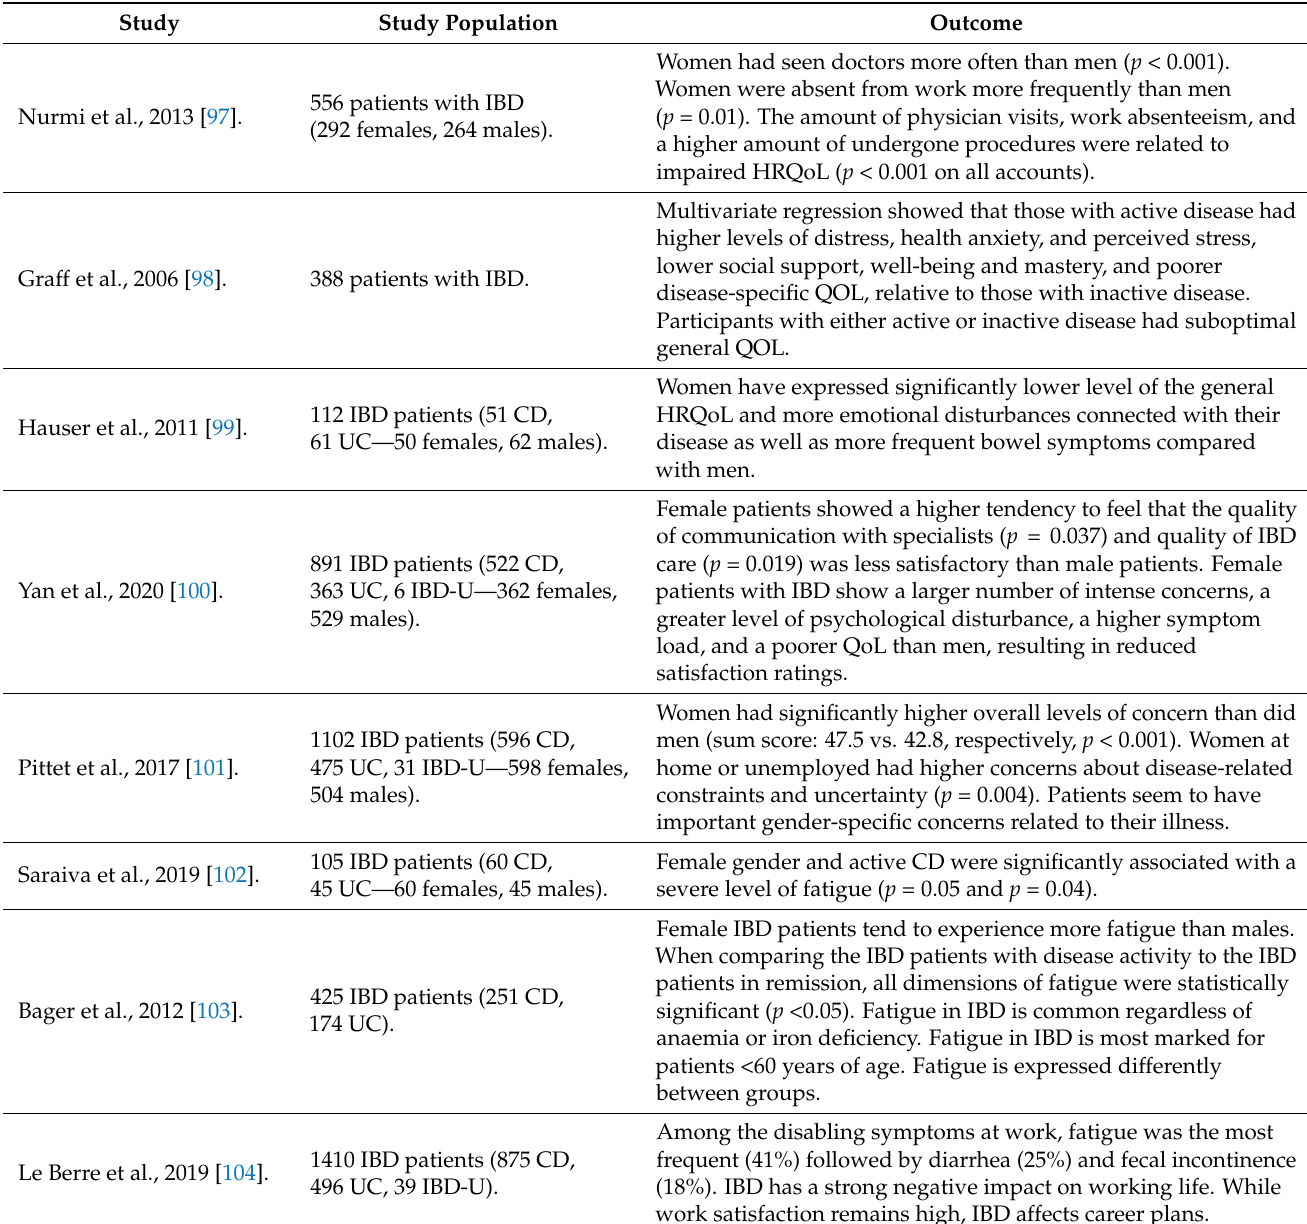
Table 4. Studies evaluating psychosocial distress, emotional disturbances and impaired QoL